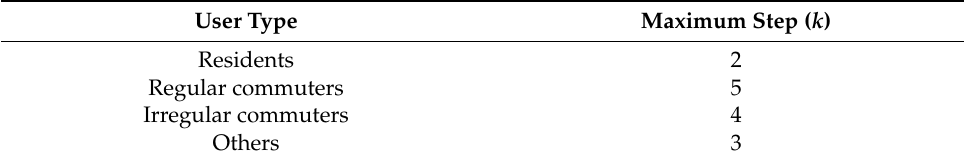
Table 6. Maximum steps for different types of users.